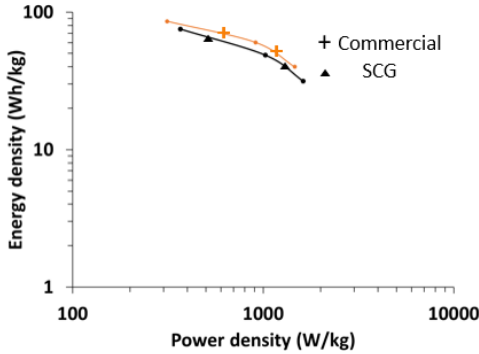
Figure 14. Comparison of Ragone plot performance of lithium ion capacitor made using prelithiated SCG Graphite and commercial graphite as anode.